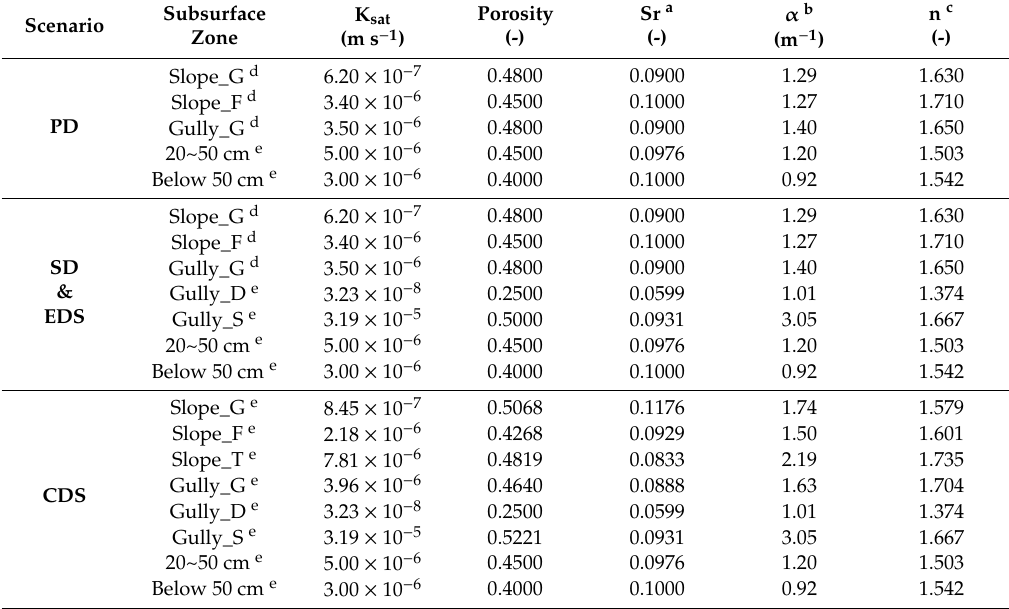
Table 5. Soil parameters used in InHM for the four